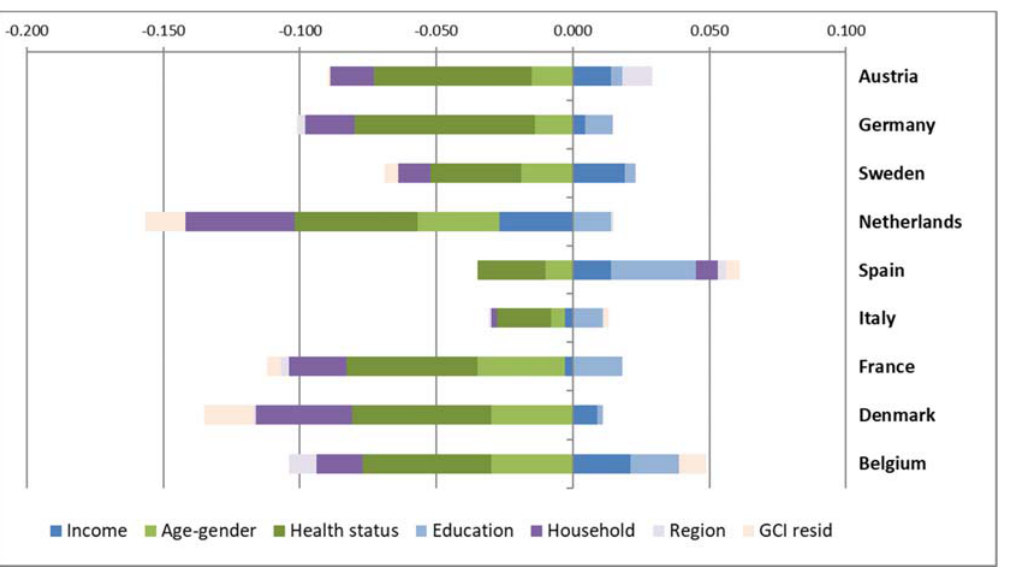
Figure 1. Decomposition of CIsin home care utilization.